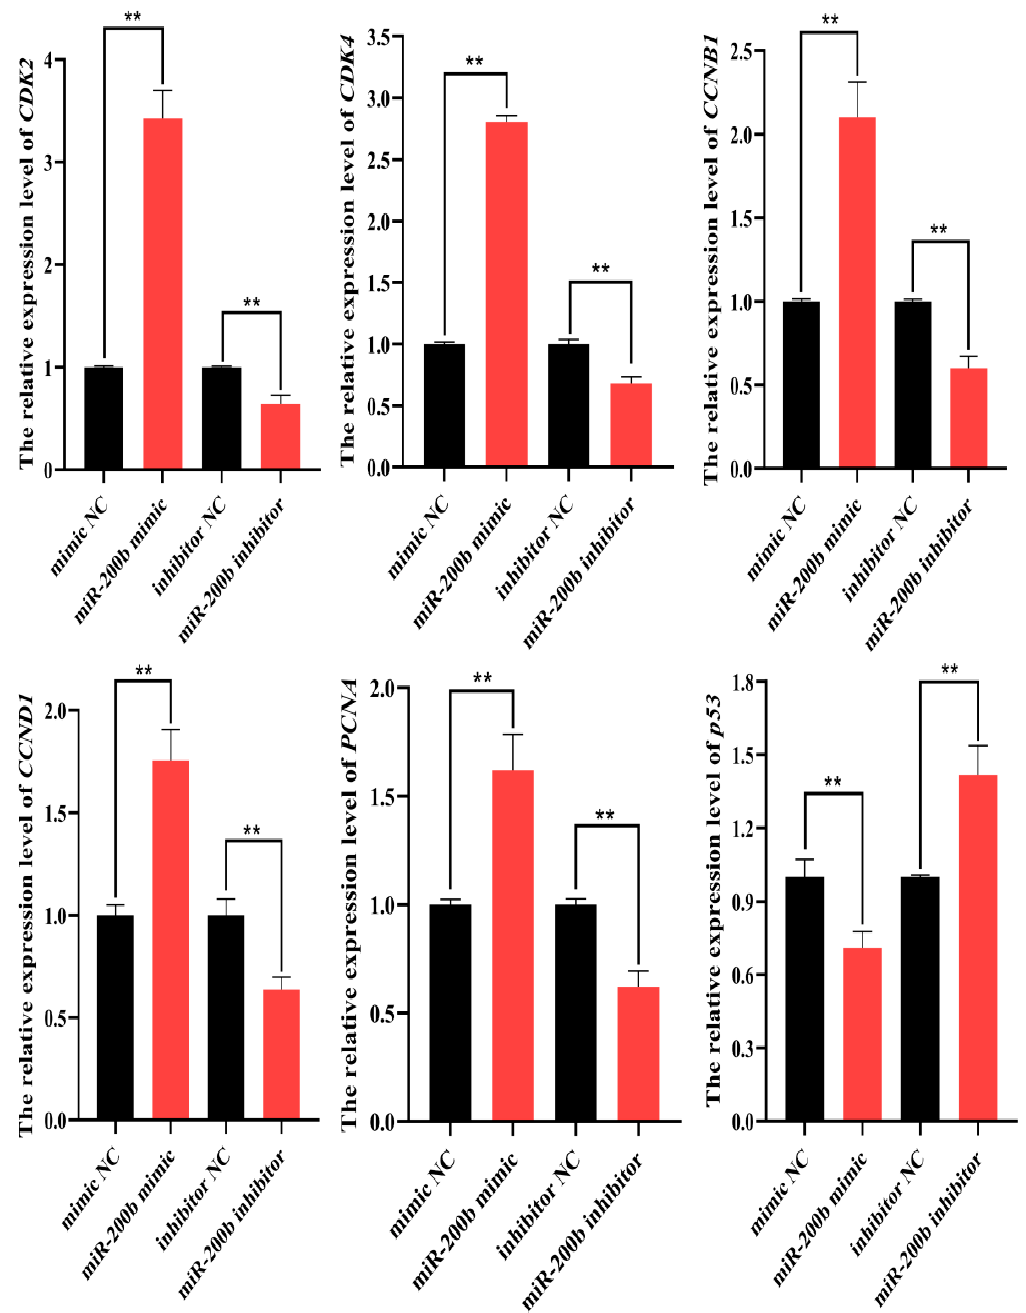
Figure 3. The expression levels of CDK2 , CDK4 , CCNB1 , CCND1 , PCNA and p53 in ovine preadipocytes on day 2 after the transfection with miR ‐ 200b mimic, miR ‐ 200b inhibitor and NC. The values represent mean ± SD ( n = 3), ** p < 0.01.